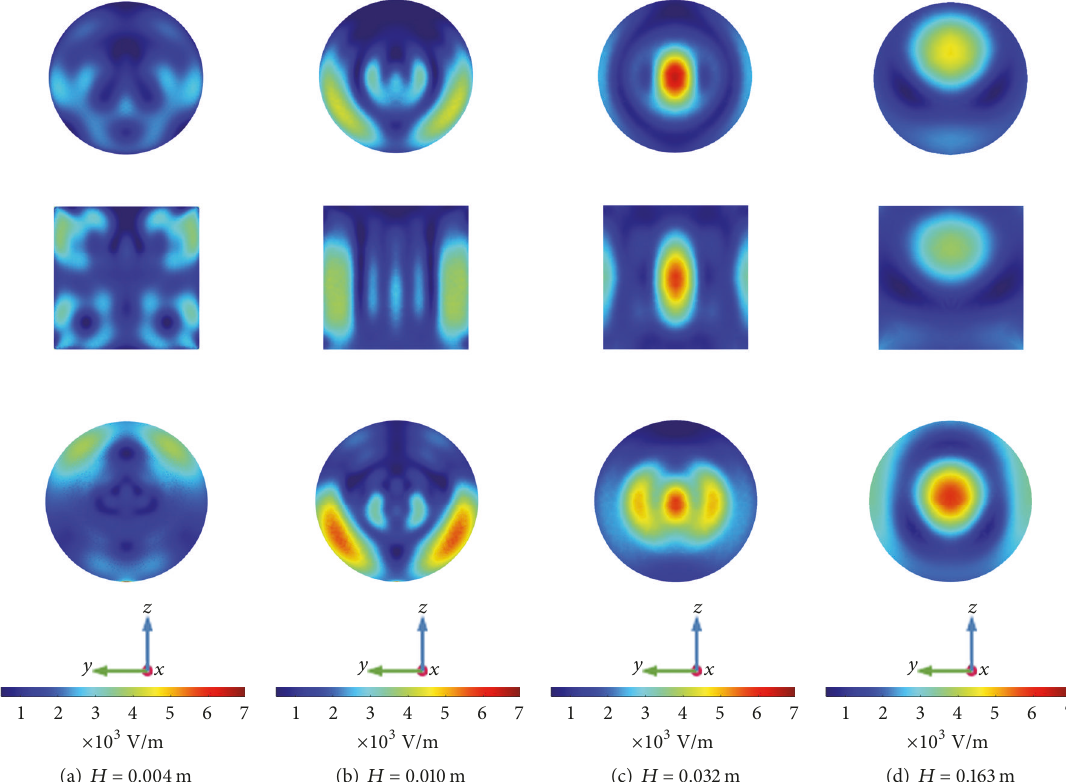
Figure 17: Electromagnetic field distribution on YZ radial middle cross section in Orientation